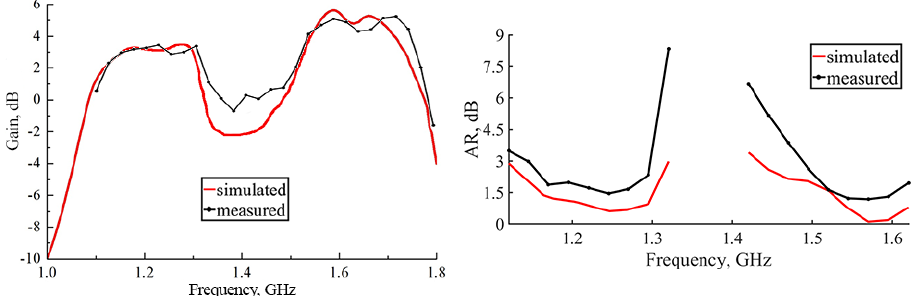
Fig. 10. Simulated and measured gain of the proposed antenna.